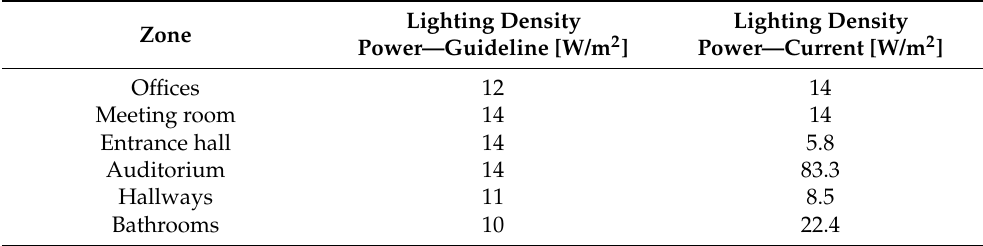
Table 5. Maximum allowed lighting density power established in the guidelines for sustainable building and current lighting density power in different locations inside the building.